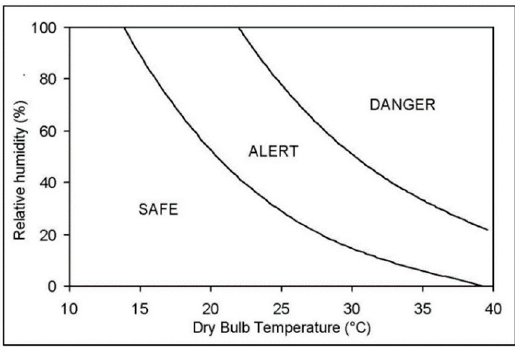
Figure 1. Thermal Comfort Zones for broiler transport defined by apparent equivalent temperature (AET) by Mitchell et al. [4]. Safe limit AET < 40 °C; danger limit Apparent equivalent temperature (AET) > 65 °C. Alert zone indicates moderate thermal stress with some degree of hyperthermia and acid-base disturbances; danger zone indicates severe thermal stress.